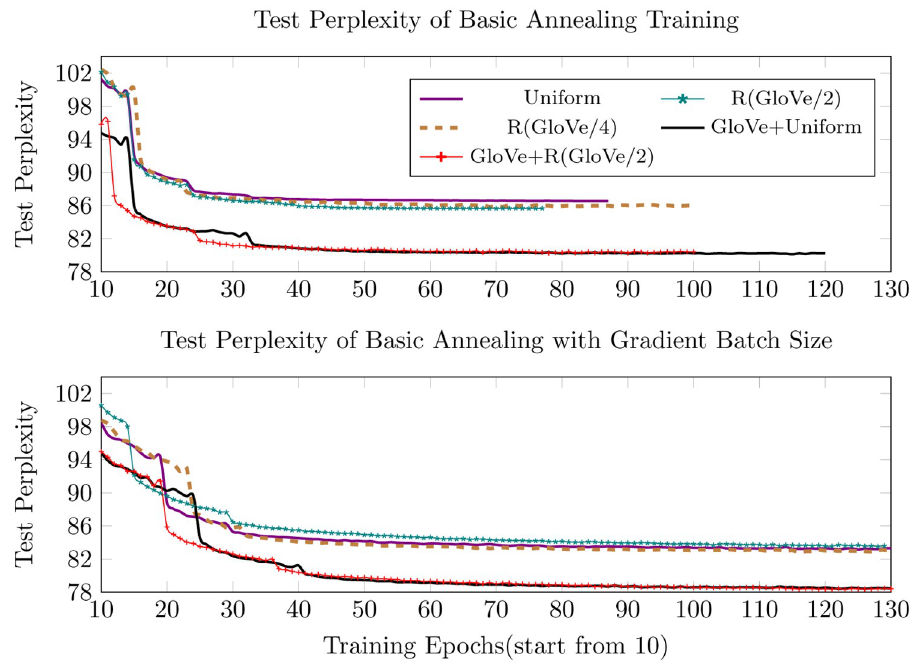
Fig 3. Test perplexity of basic annealing and gradient batch